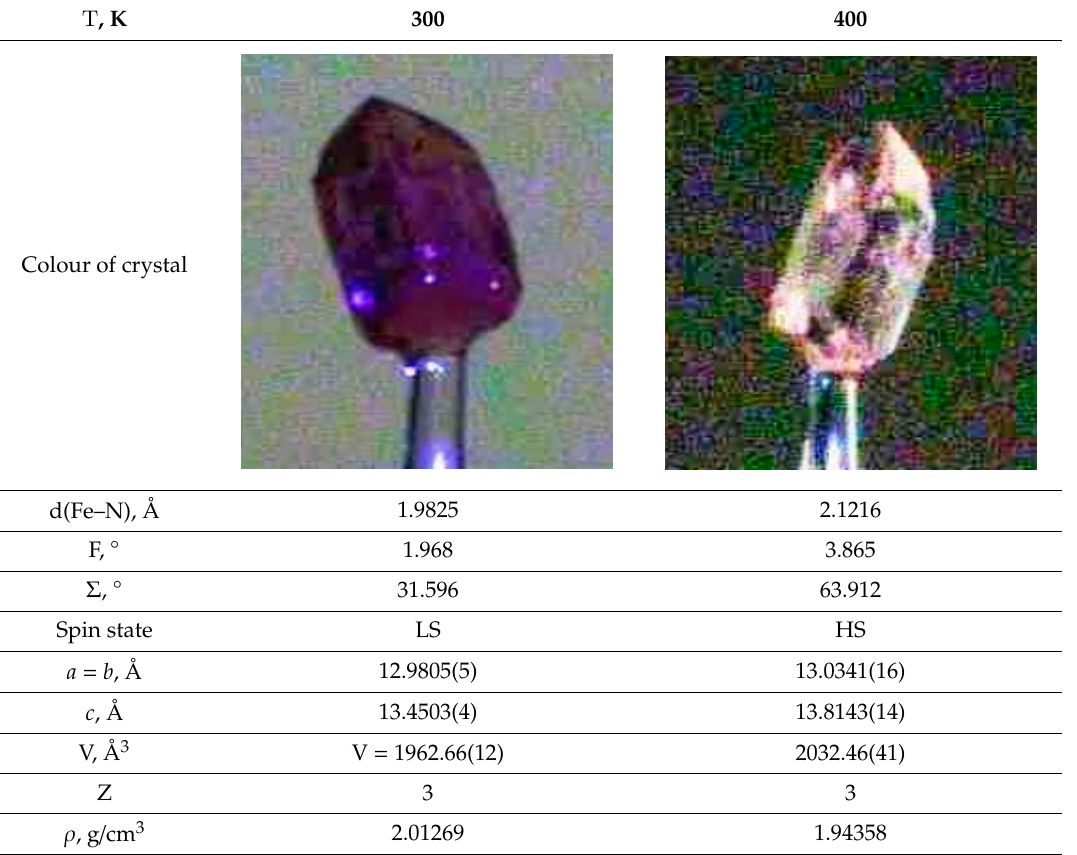
Table 2. Basic geometric characteristics of the iron(II) environment in complex [Fe(HC(pz) 3 ) 2 ]SiF 6 . Т , K